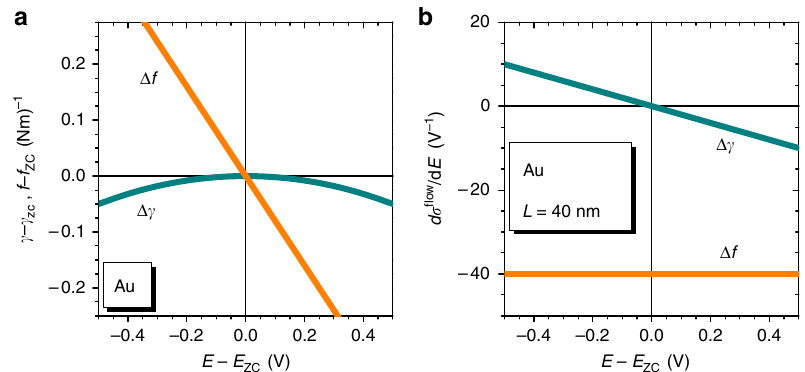
Fig. 2 Capillary forces at gold surfaces and their impact on the fl ow stress of a nanowire. a Linear variation of surface stress, f , with electrode potential, E , around the potential of zero charge, E zc , is distinguished from parabolic variation of the surface tension, γ . b Flow-stress potential coupling parameter, d σ fl ow /d E , vs. E . Qualitatively different predictions for the coupling are obtained depending on whether σ fl ow is assumed to respond to changes in γ , Eq. (12), or in f . Graphs show extrapolated behavior based on the quadratic and linear approximations of Eqs. (10) and (11) along with experimental values for capacitance and electrocapillary coupling of gold near E zc , see main text. b Assumes ligament diameter 40 nm, representative of the